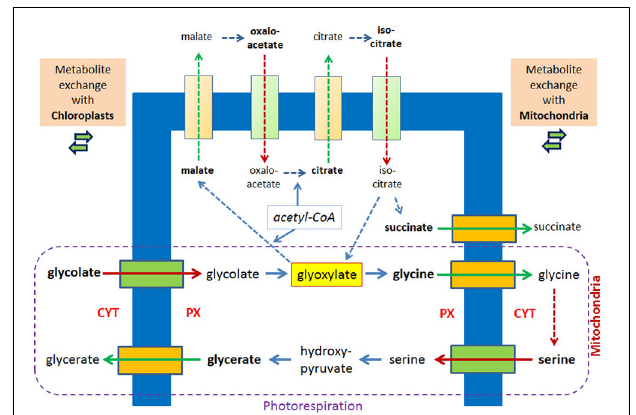
FIGURE 3 | Metabolite transport processes for the glyoxylate cycle and the photorespiratory process are considered to be similar. In plant peroxisomes glyoxylate is a key metabolite of the glyoxylate cycle and the photorespiration, the latter involving mitochondria and chloroplasts. Hypotheticalpore-formingproteinspermitting the exportare coloredorange, hypothetical pore-forming proteins permitting the import are colored green. The broken lines with arrow heads indicate reactions of the glyoxylate cycle and the conversion of two molecules of glycine into serine inside mitochondria without further details. Reactions of the photorespiration process are